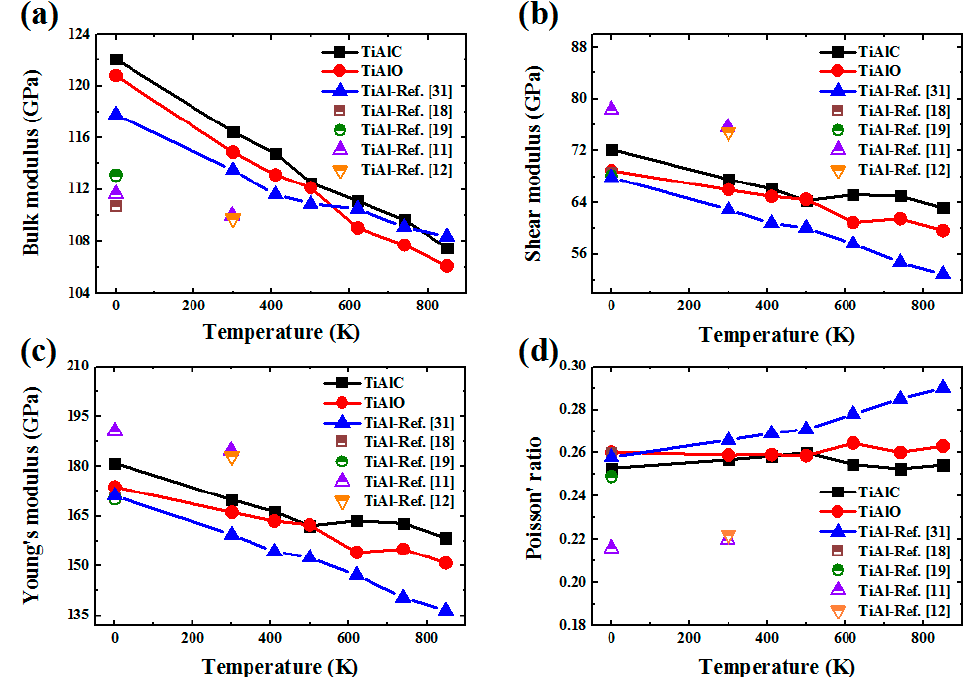
Figure 7. The calculated temperature dependent elastic modulus of ( a ) bulk modulus ( B ), ( b ) shear modulus ( G ), ( c ) Young’s modulus ( E ), and ( d ) Poisson’s ratio ( ν ) for TiAlC, TiAlO and pure γ -TiAl.